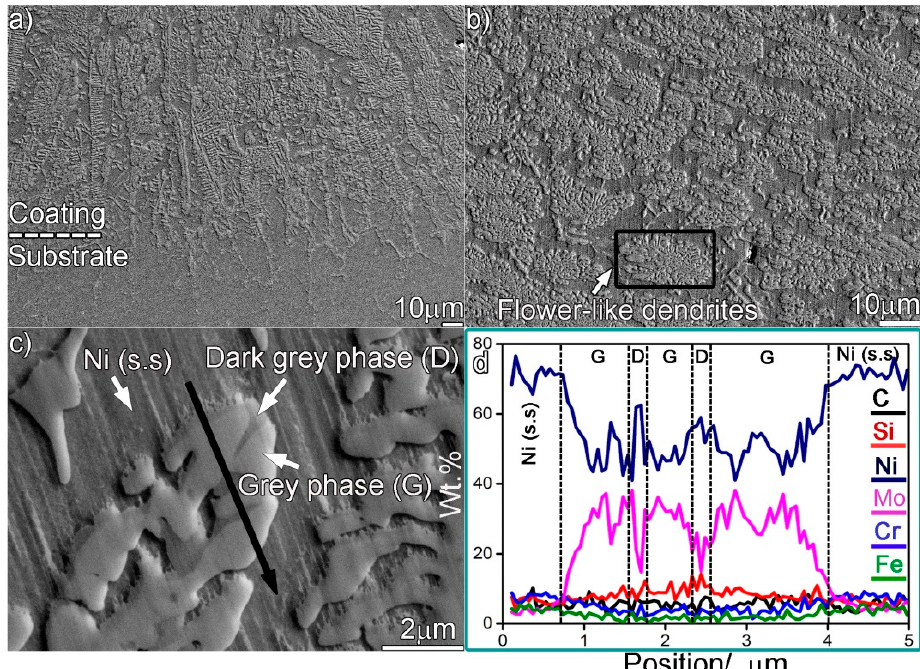
Figure 6. SEM secondary electron micrographs showing the microstructure in the coating aged for 240 h: ( a ) at the interface, ( b ) at the upper part, ( c ) magnified morphology of the upper part, and ( d ) elemental line scan analysis across black line in ( c ).